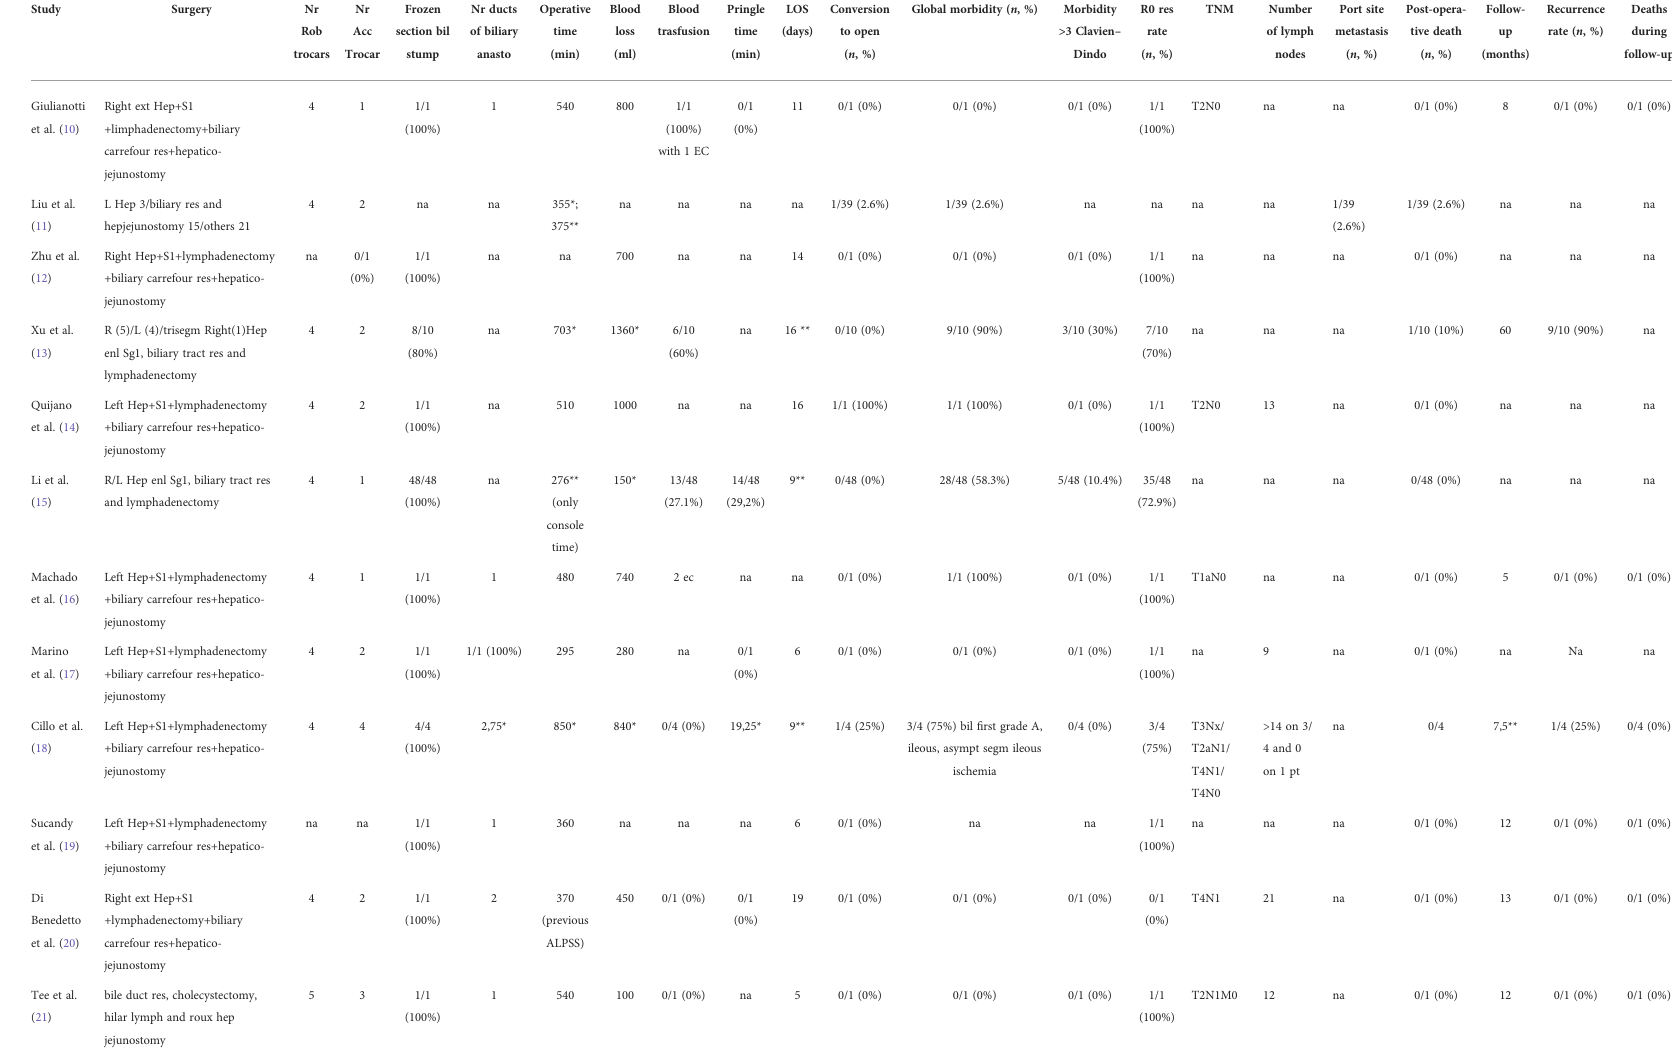
TABLE 2 Studies on robotic surgery for HC: study, patients, and procedural characteristics.